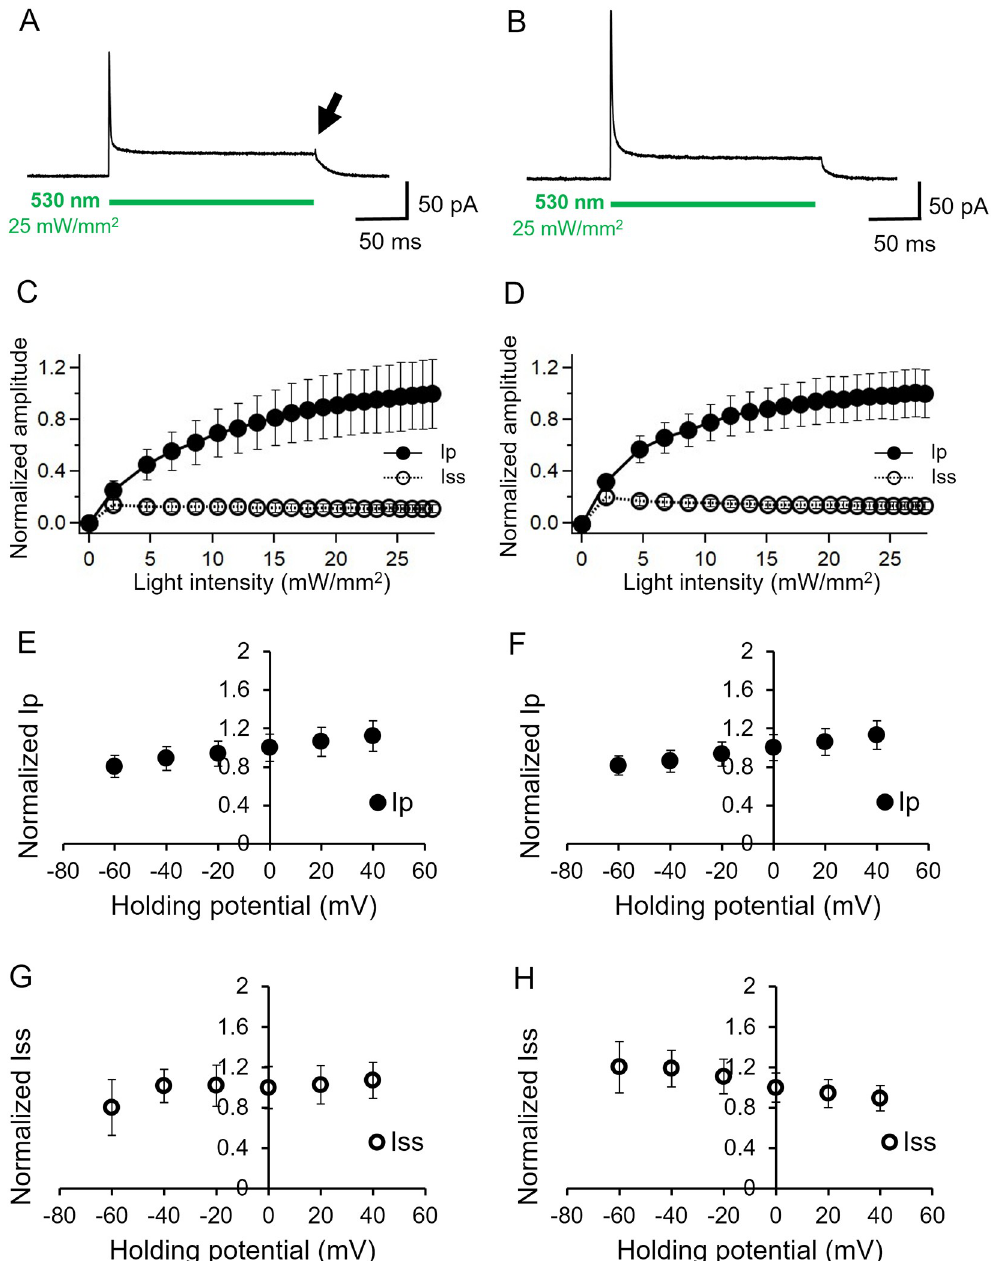
Fig 1. Basic characterization of KR2 photocurrent in ND7/23 cells. Representative photocurrent at 0 mV in the absence (A) and presence (B) of 110 mM NaCl in intracellular solution while the bath solution contained 140 mM NaCl. pHs were adjusted at 7.4 for both solutions. See Table for more details. 530 nm light (25 mW/mm 2 ) was illuminated for 200 ms as the green bar indicates. C and D, light power dependency on the peaks (I p ) and steady state (I ss ) photocurrent, in the absence and presence of NaCl intracellular solution, respectively (n = 7). E and F, Current-voltage relation (I/V plot) for the peak current (n = 12, 9). The currents were normalized to the value at 0 mV. G and H, Current-voltage relation (I/V plot) for the steady state component. The currents were normalized to the value at 0 mV (n = 12, 9).